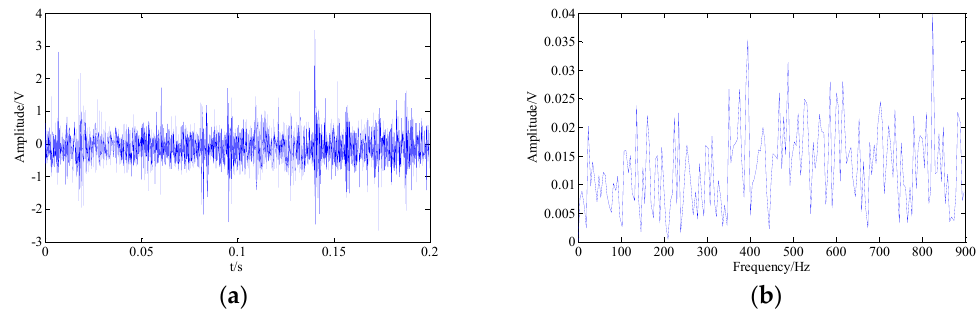
Figure 13. The response of measured vibrational signal: ( a ) collected composite original single channel signal in time-domain; and ( b ) collected composite original single channel signal in frequency-domain.